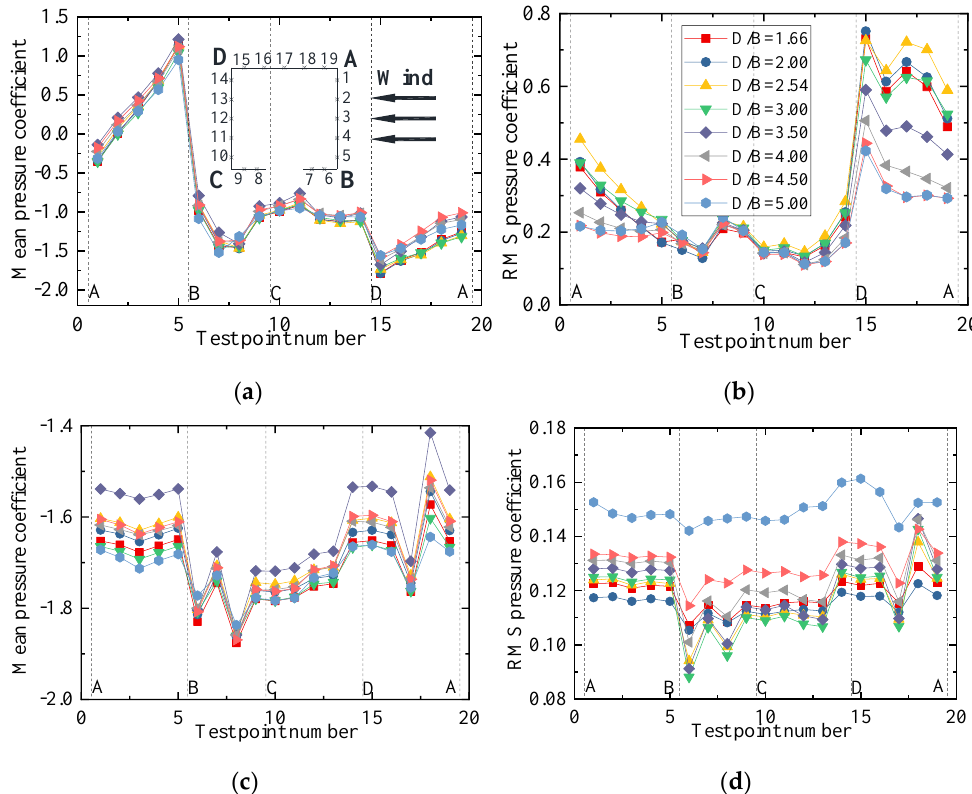
Figure 20. Wind pressure coefficient of the downstream bridge for Case 3: ( a ) Mean values of the outer taps; ( b ) RMS values of the outer taps; ( c ) Mean values of the inner taps; ( d ) RMS values of the inner taps.